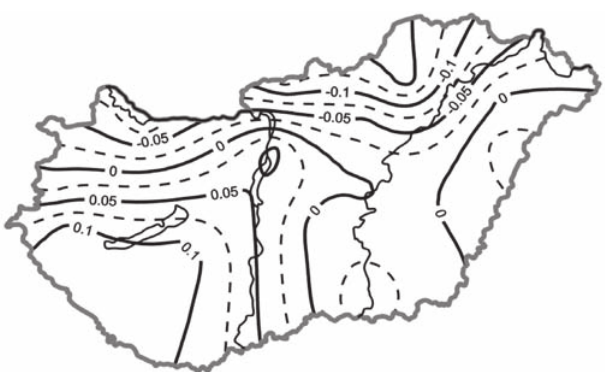
Figure 14 – The spatial distribution of mean daily slope values of the trend-function expressing the changes of the absolute daily maxima of precipitation in winter according to data raised at 16 stations over 1951–2010.